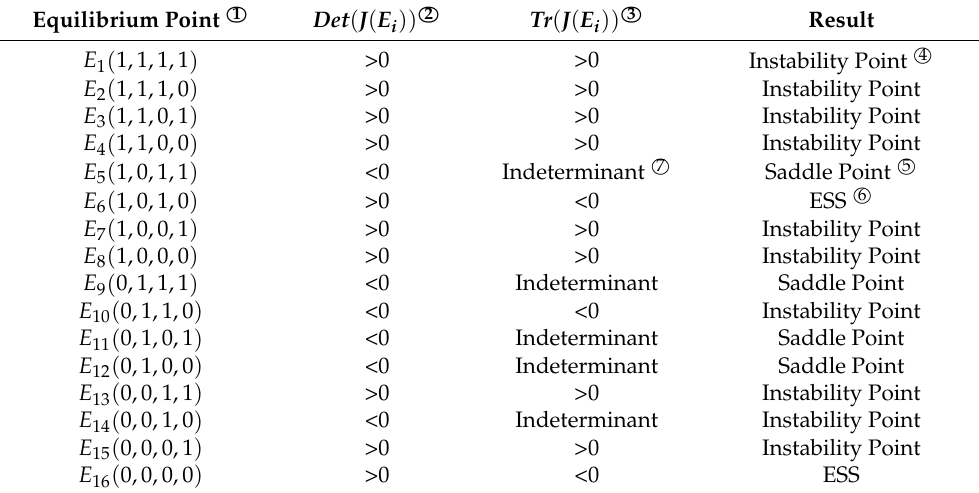
Table 3. Analysis of Evolutionary Stability of Equilibrium